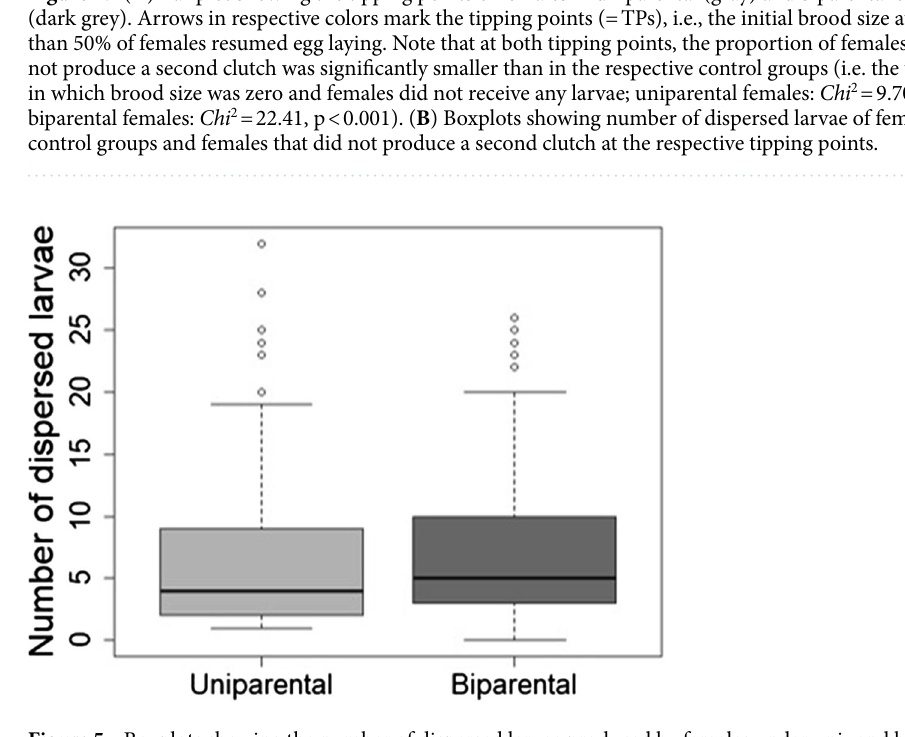
Figure 5. Boxplots showing the number of dispersed larvae produced by females under uni- and biparental